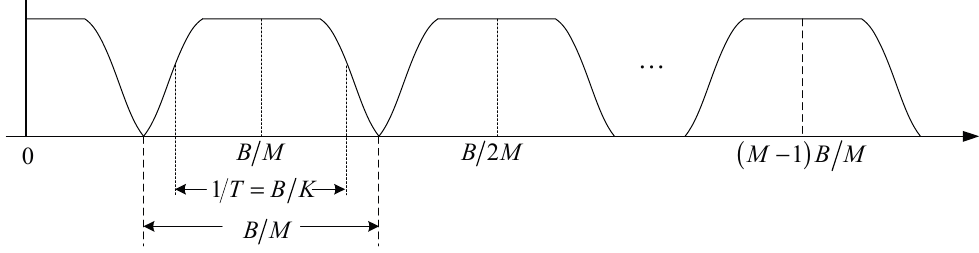
Figure 2. The complex baseband spectrum of the transmit FMT